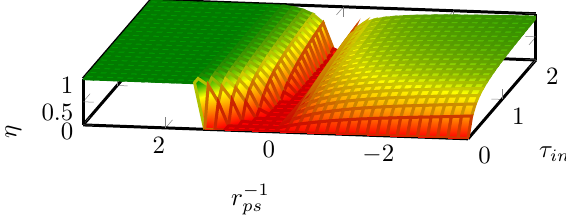
Figure 17. Efficiency for positive output velocities.